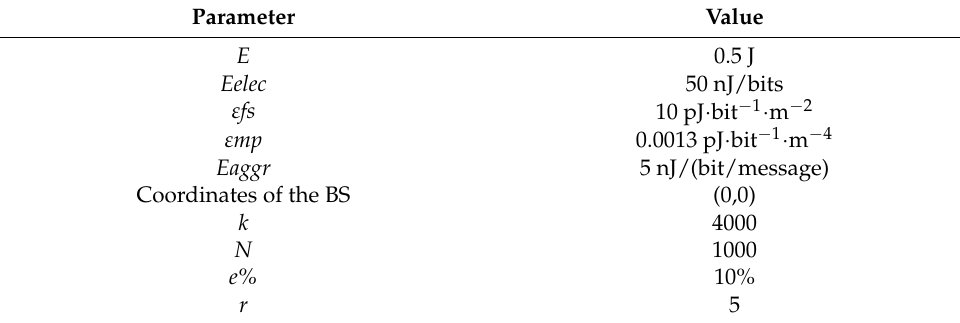
Table 3. Initial setting of simulation